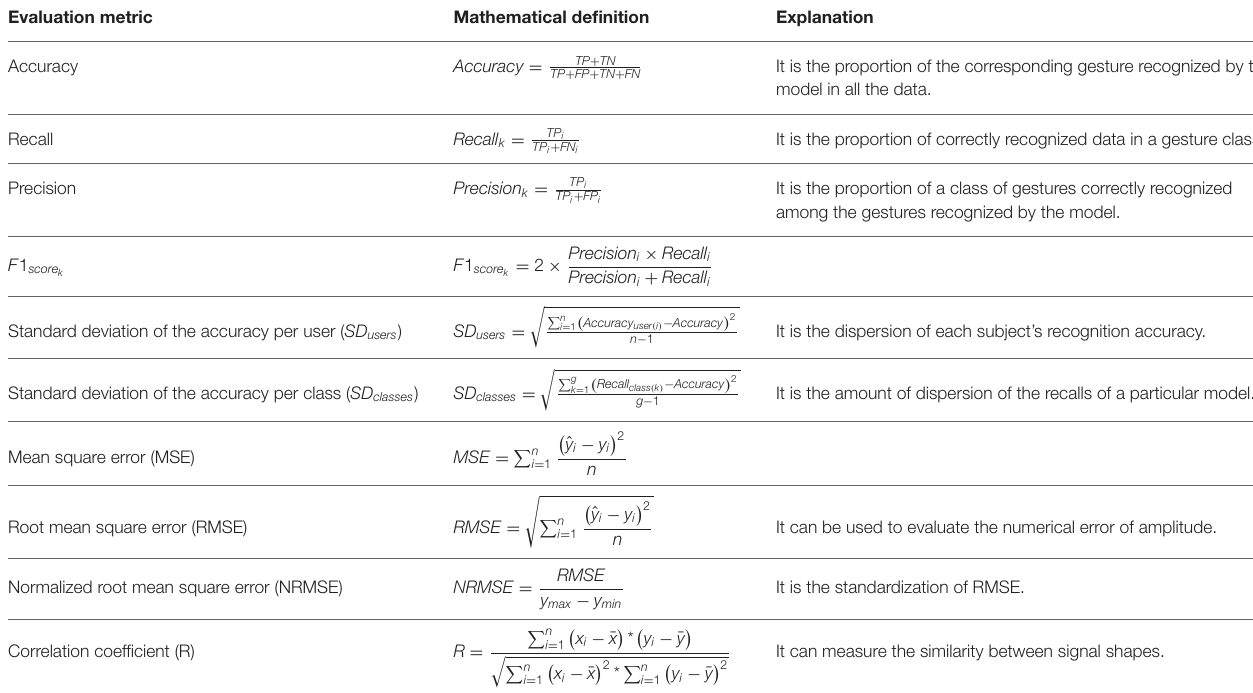
TABLE 3 | The commonly used offline performance metrics.